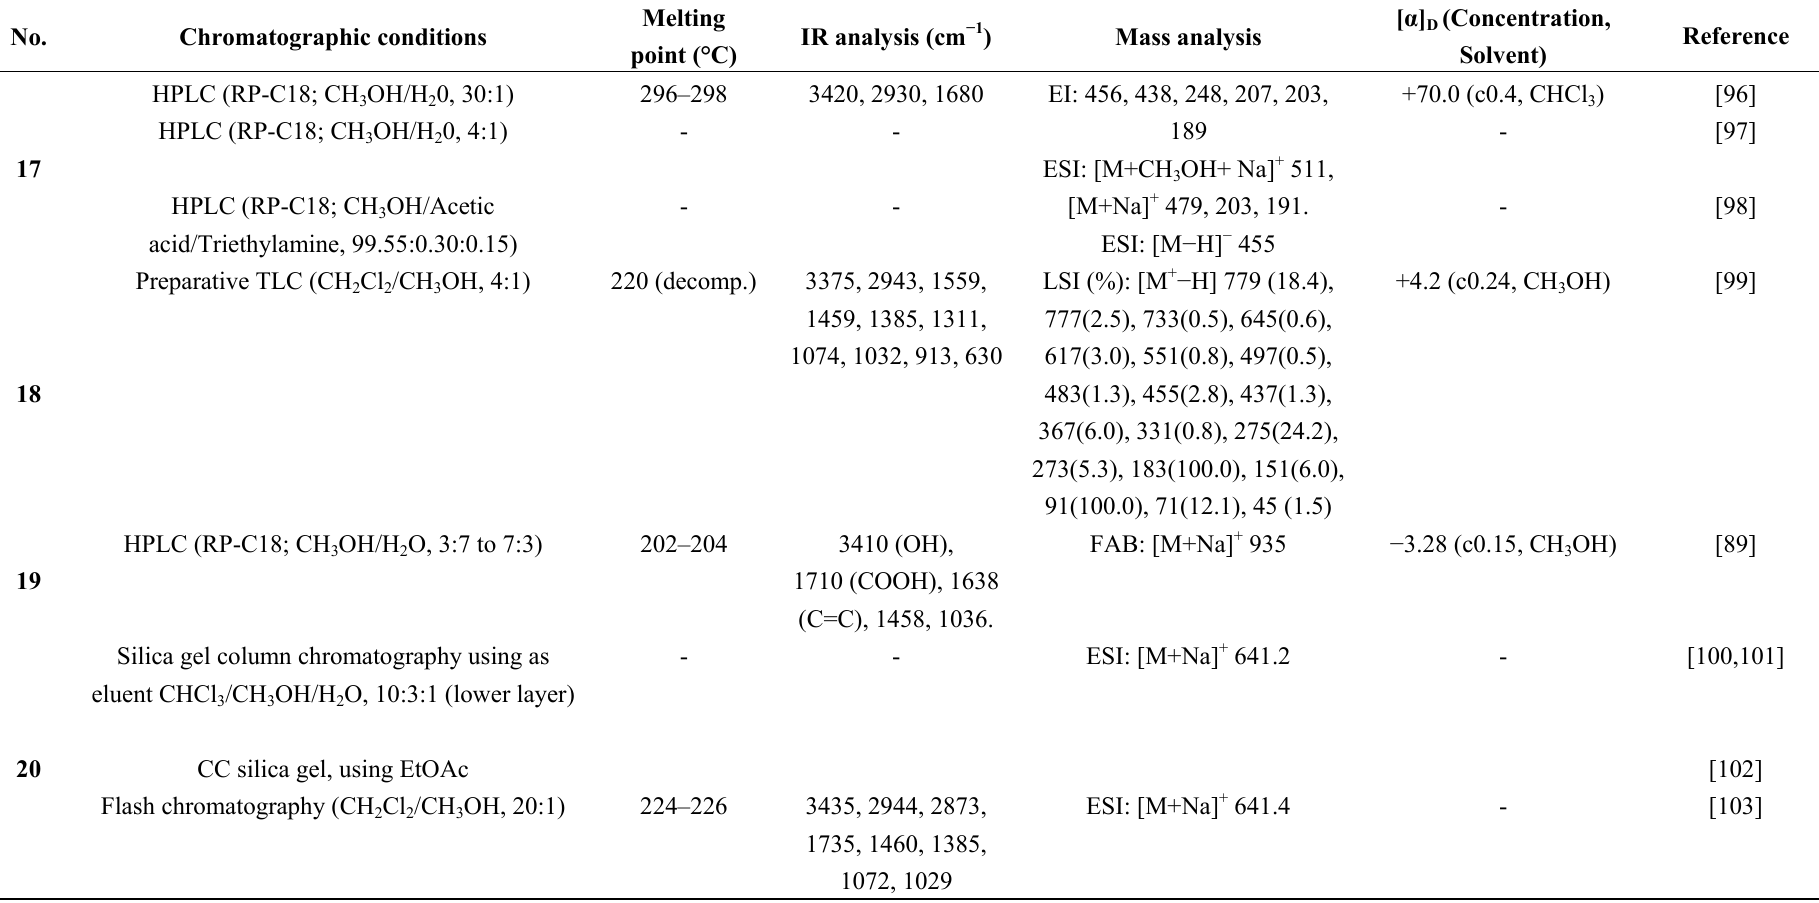
Table 5. Purification and biophysical properties of oleanes gem-dimethylated isolated from Gymnema sylvestre